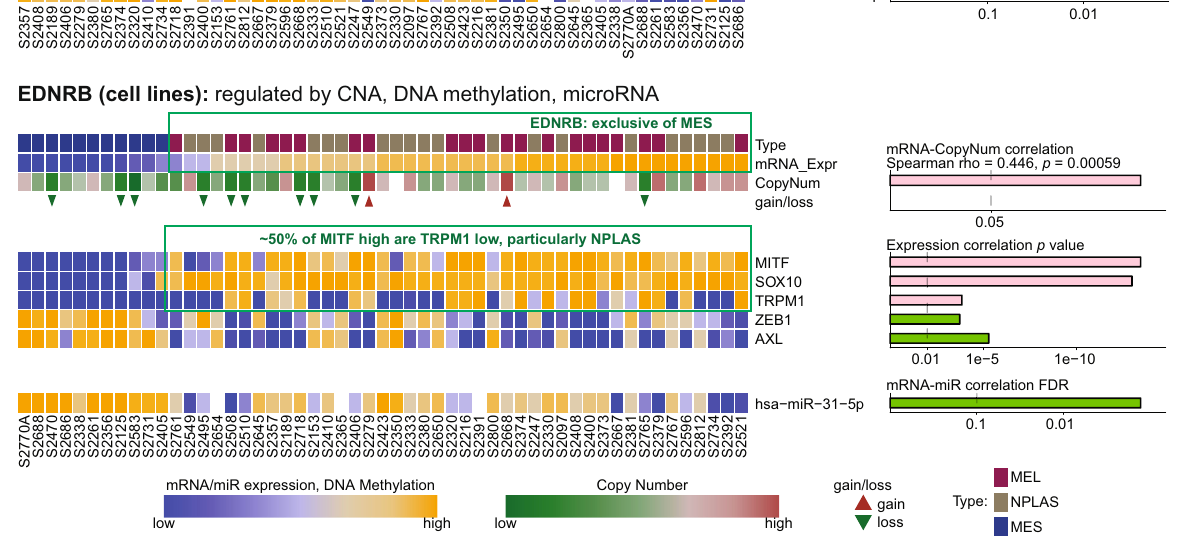
annotation, a strong trend for differential response by MCS remained at the on-treatment time point ( p = 0.051). Of the 42 patients with longitudinal samples and known response status, 9 displayed discordant MCS categories when we compared on-treatment with pre-treatment samples. A MEL-wise shift occurred in 2 patients (1 MES to NPLAS, 1 NPLAS to MEL) who were both non-responders. In contrast, a MES-wise shift NATURE COMMUNICATIONS| (2022) 13:4000